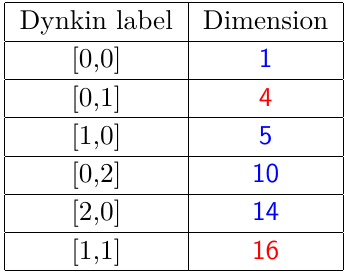
Table 8 . so (5) irreducible representations [9].